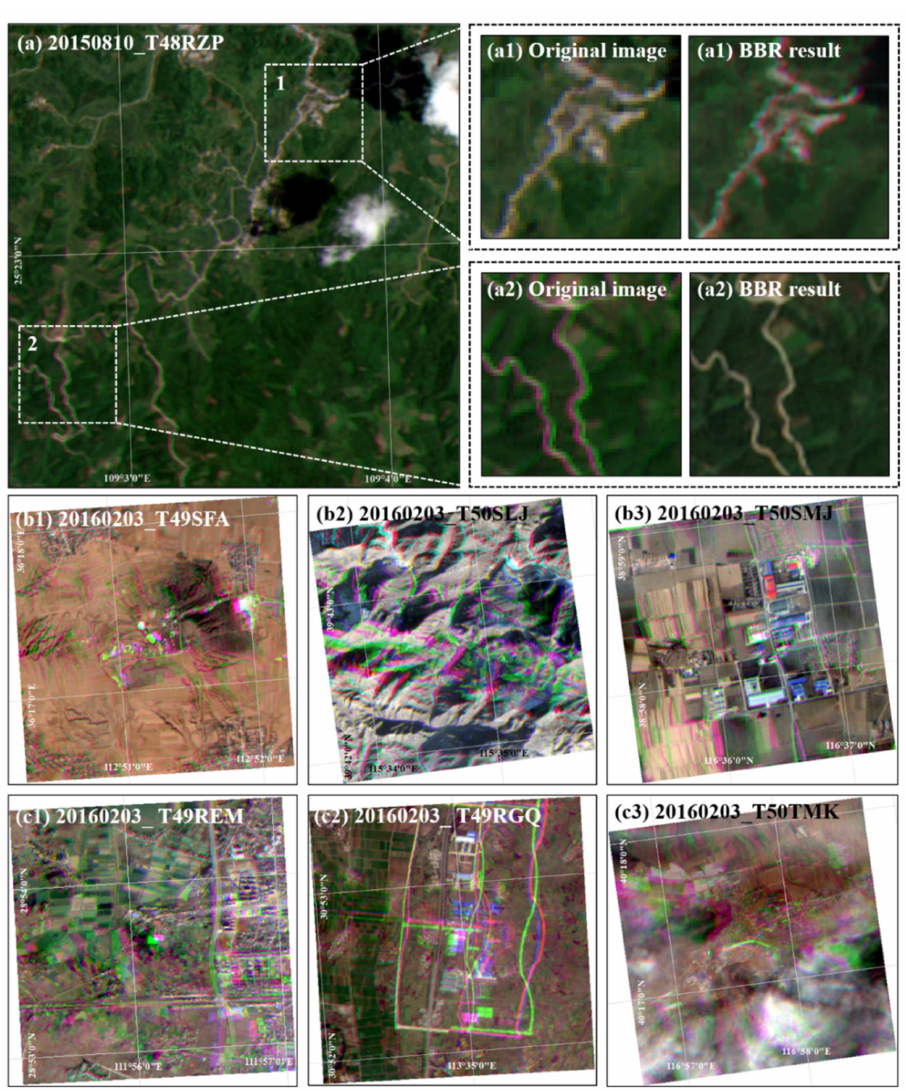
Figure 7. Examples of areas with complex inter-band offset. ( a ) The inter-band offset only appeared in part of the chip of 20150810_T48RZP, and the BBR of ( a2 ) leads to a new error in ( a1 ). ( b1 – c3 ) Some complex offset acquired on 3 February 2016; the offset in ( b1 – b3 ) can be detected, but the registration effect is limited; the offset in ( c1 – c3 ) cannot be